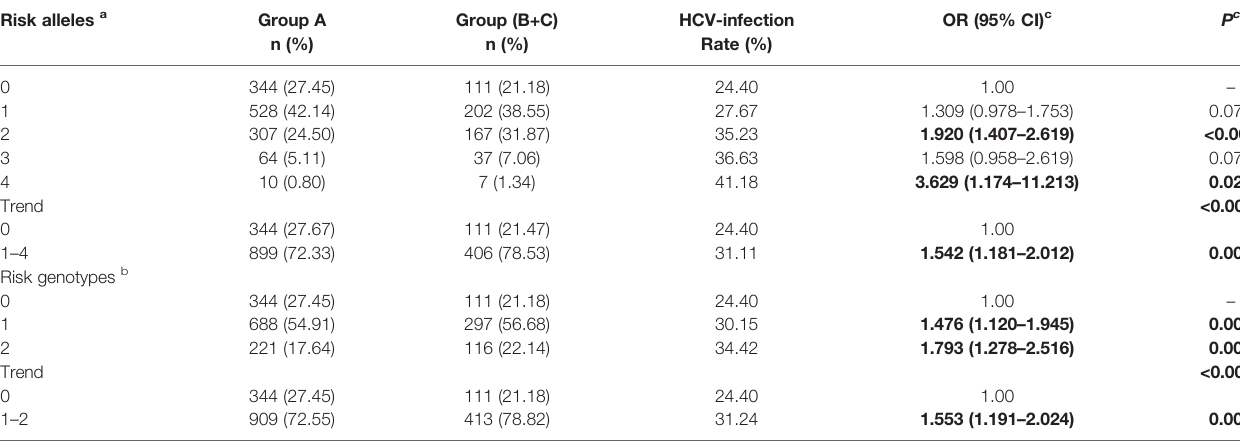
TABLE 3 | The combined effects of risk alleles and genotypes on the risk of HCV infection. Risk alleles a Group A Group (B+C) HCV-infection